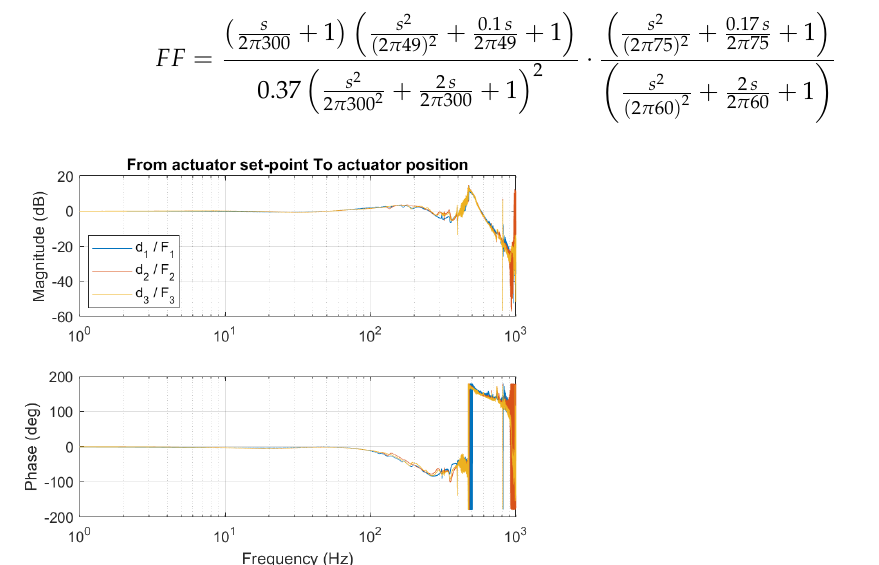
Figure 15. Closed loop frequency response of the actuators, from actuator reference position to measured